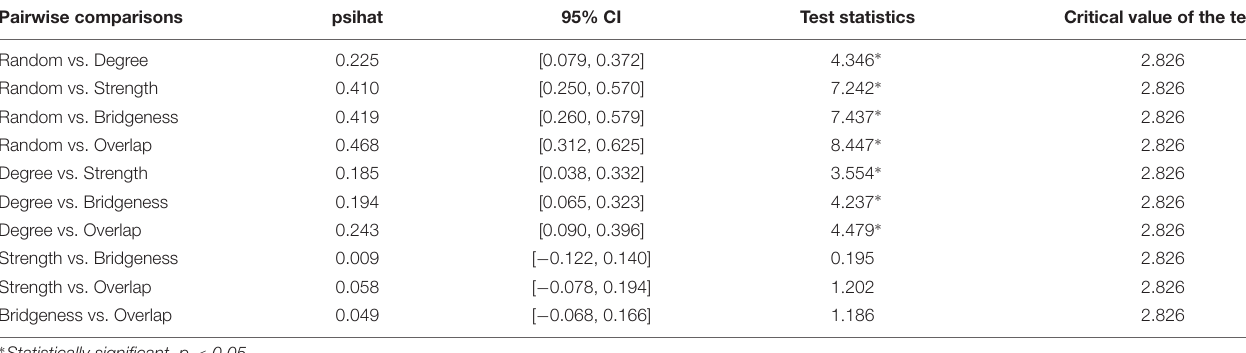
TABLE 5 | Post hoc comparisons between attack conditions of the extent of the attack on the average path length in the network. Pairwise comparisons psihat 95% CI Test statistics Critical value of the test Random vs.